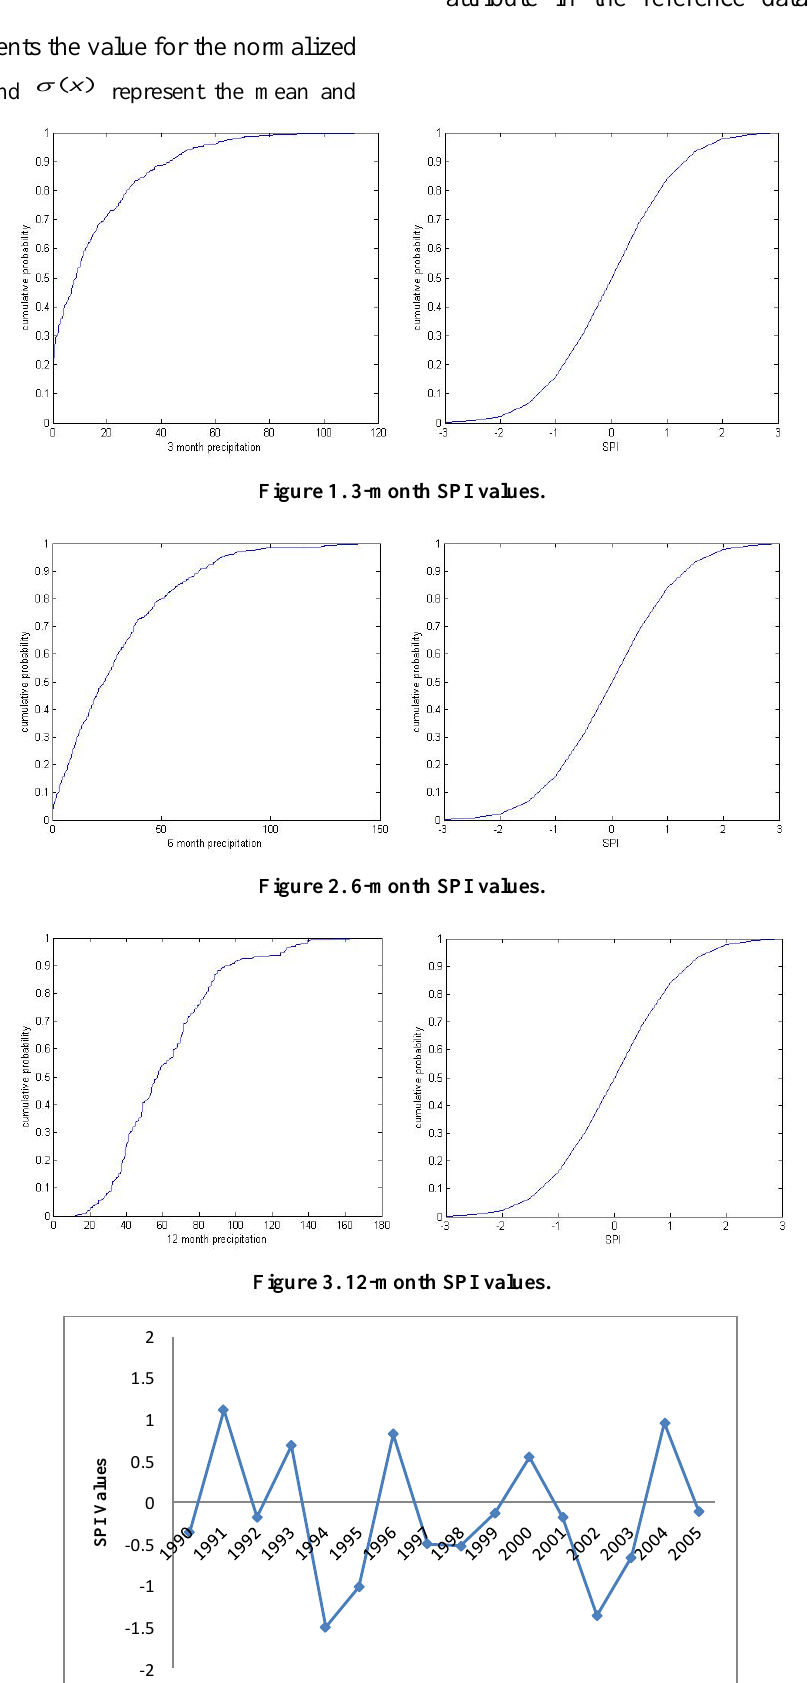
Figure 4. SPI values for first